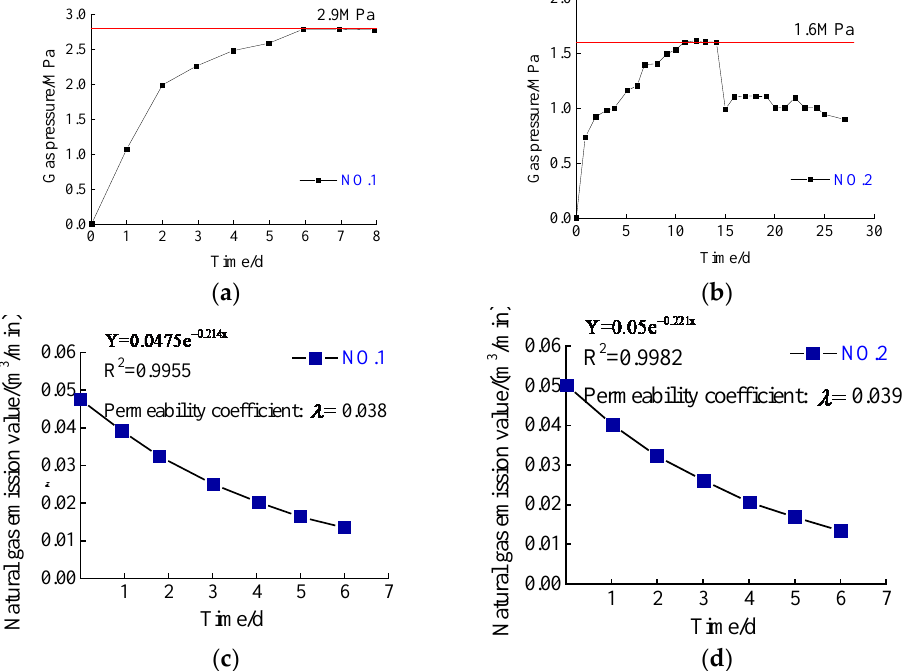
Figure 5. Wu protects Ji area: ( a ) NO. 1 measuring point gas pressure test data; ( b ) NO. 2 measuring gas pressure point test data; ( c ) NO. 1 measuring point permeability coefficient test data; ( d ) NO. 2 measuring point permeability coefficient test data.